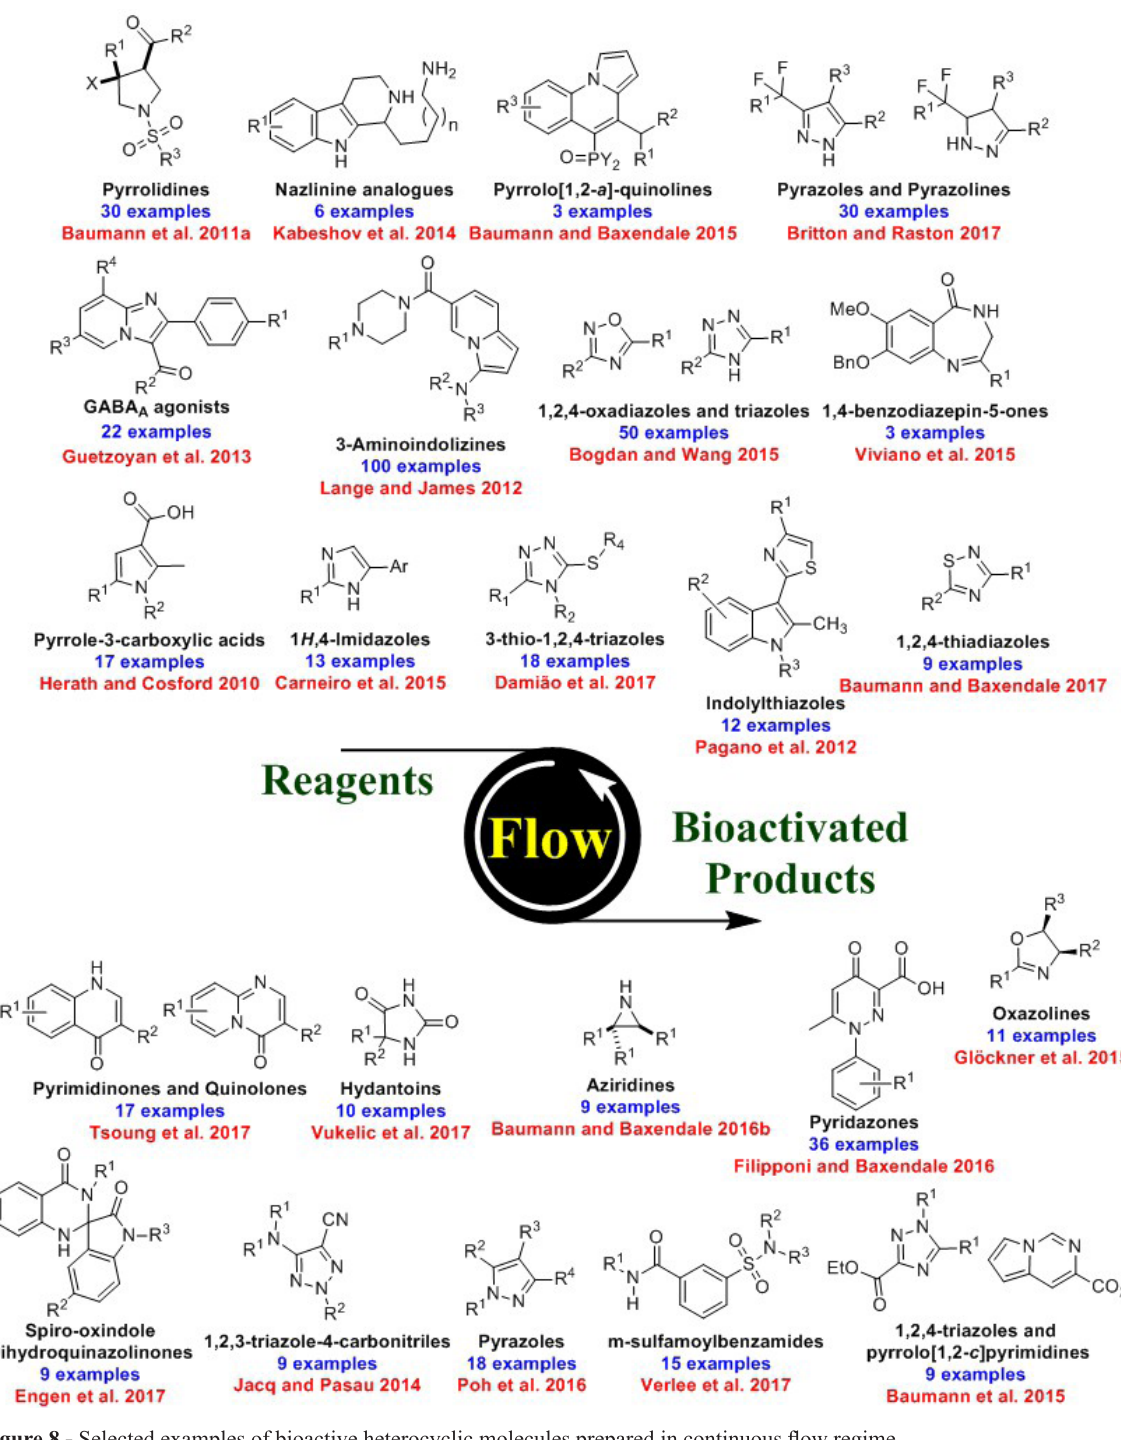
Figure 8 - Selected examples of bioactive heterocyclic molecules prepared in continuous flow